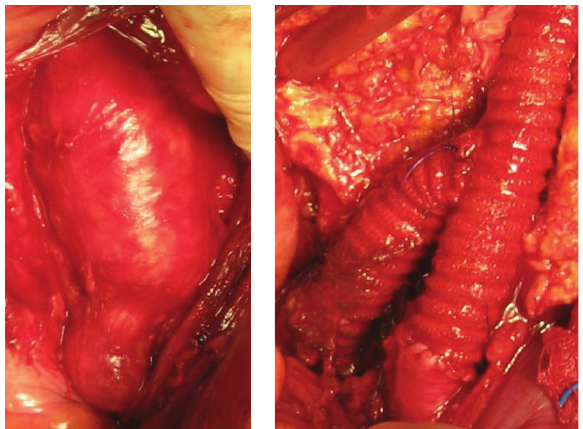
Figure 4: Intraoperative view of left common and internal iliac artery aneurysms and